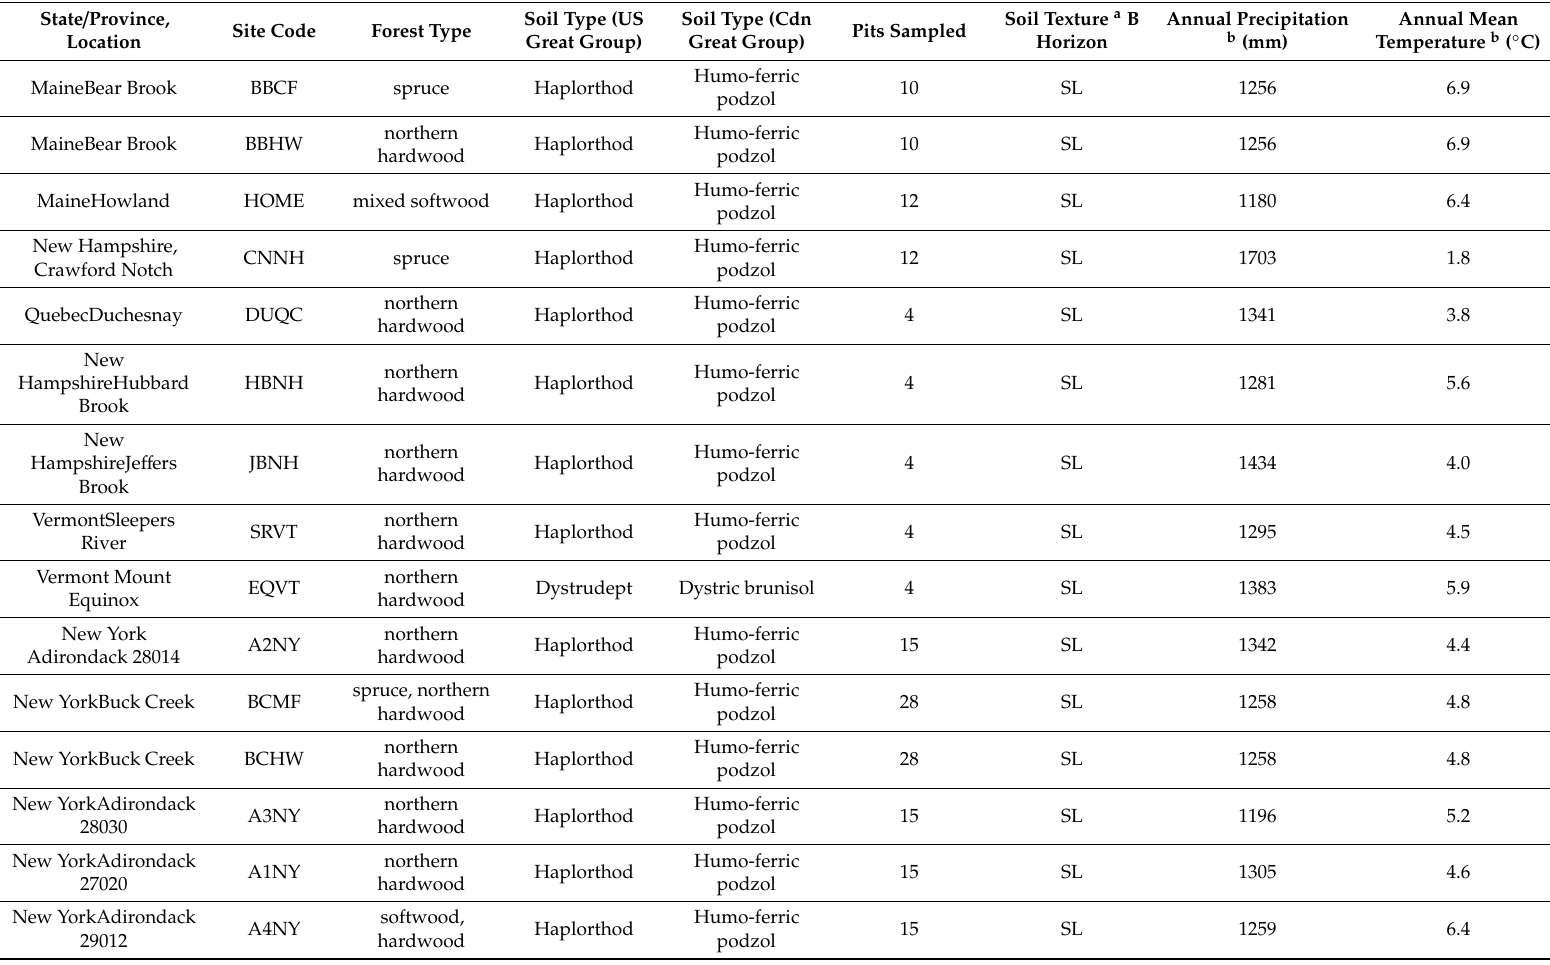
Table 1. Location, site characteristics and sampling description for soil resampling sites in Eastern Canada (Cdn) and the Northeastern United States (US). Ordered from east to